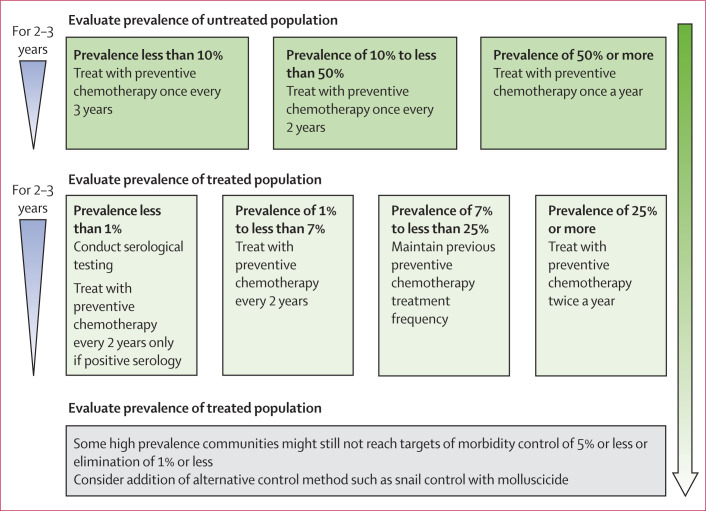
Modified adaptive strategy for schistosomiasis morbidity controlThe added modifications are: (1) to decrease the time interval between initiation and evaluation of treatment strategy outcomes to 2–3 years due to projected stagnation of further treatment impact, and (2) to lower the prevalence threshold for switching from annual to biannual treatment strategies. Although we chose to use 7% and 25% as the cutoff thresholds during the changeover year, these values are not rigid and could be adjusted as needed for local conditions.